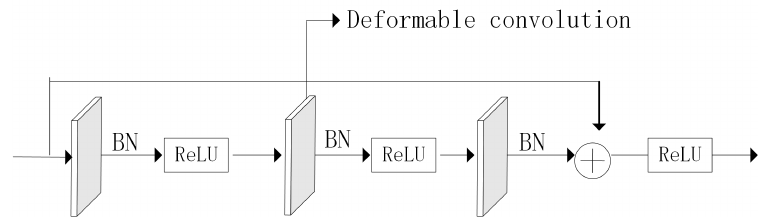
Figure 4. Intra-scale cost